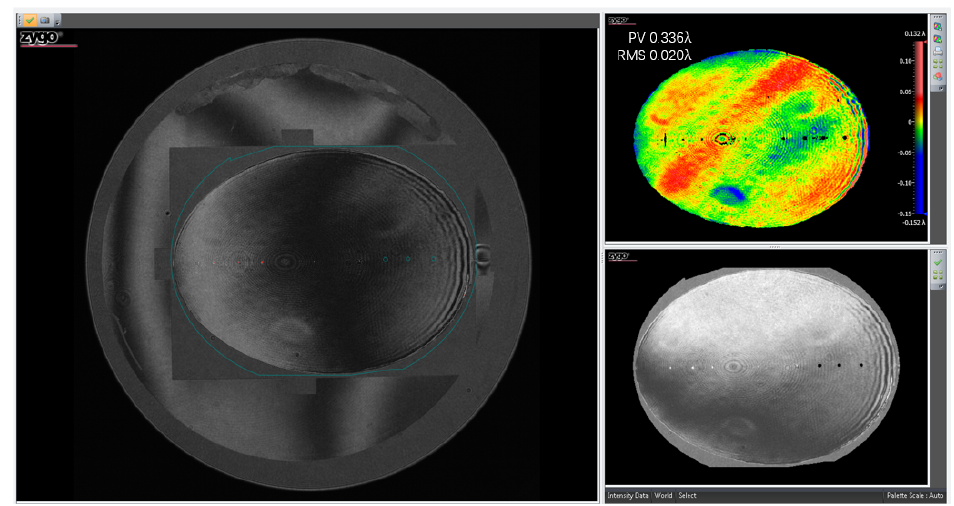
Figure 22. Mirror surface error after the vibration test.